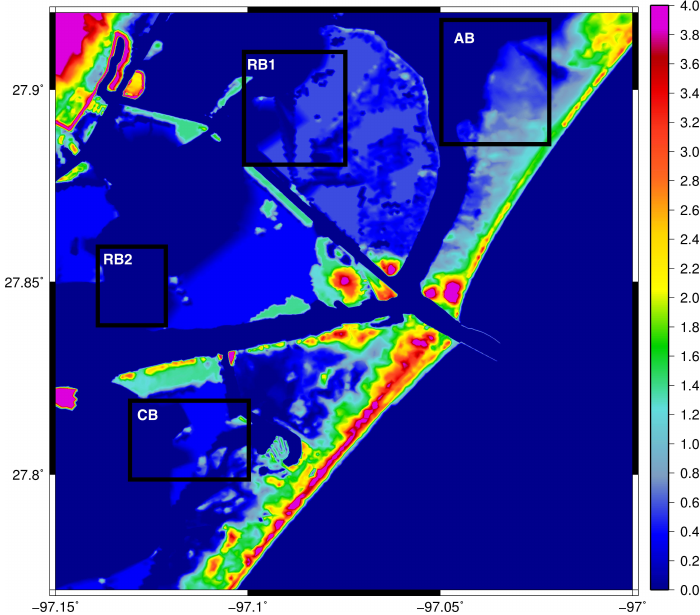
Figure 12. Monitoring locations for